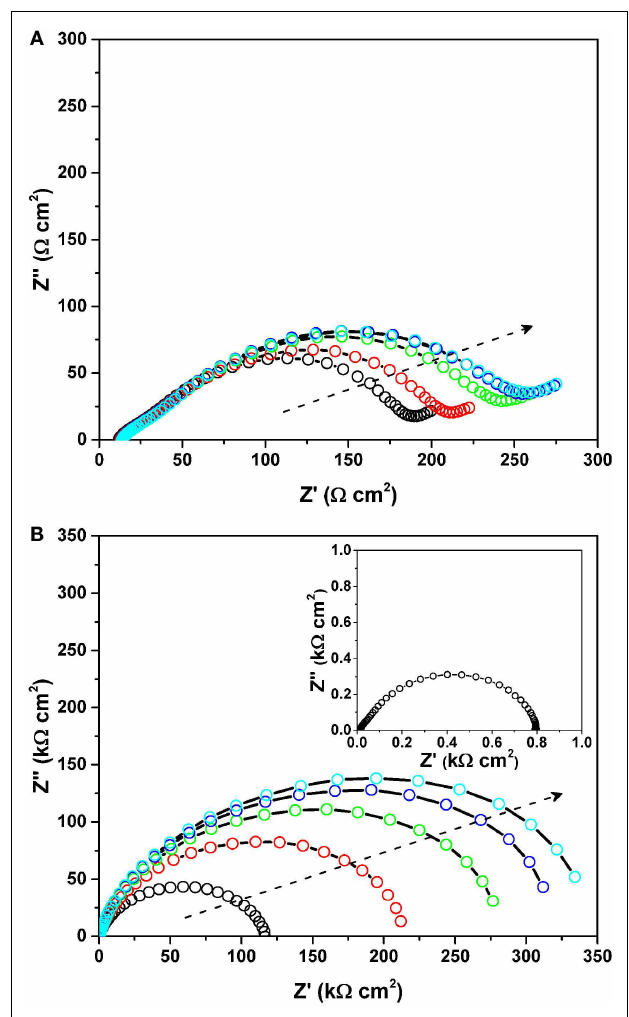
FIGURE 5 | Nyquist plots of the symmetrical (A) MnO 2 /MnO 2 cell and (B) Mg/Mg cell (as a function of holding time) under OCV .The impedance of the symmetrical cells was recorded every 3h (up to total 12h). All impedance data were collected under OCV and the lowest frequency was 0.1 and 0.01Hz for the cathode and anode studies, respectively.The arrows represent an increase of the holding time.The inset in (B) shows the Nyquist plot of the Mg/Mg symmetrical cell measured under a bias voltage of +